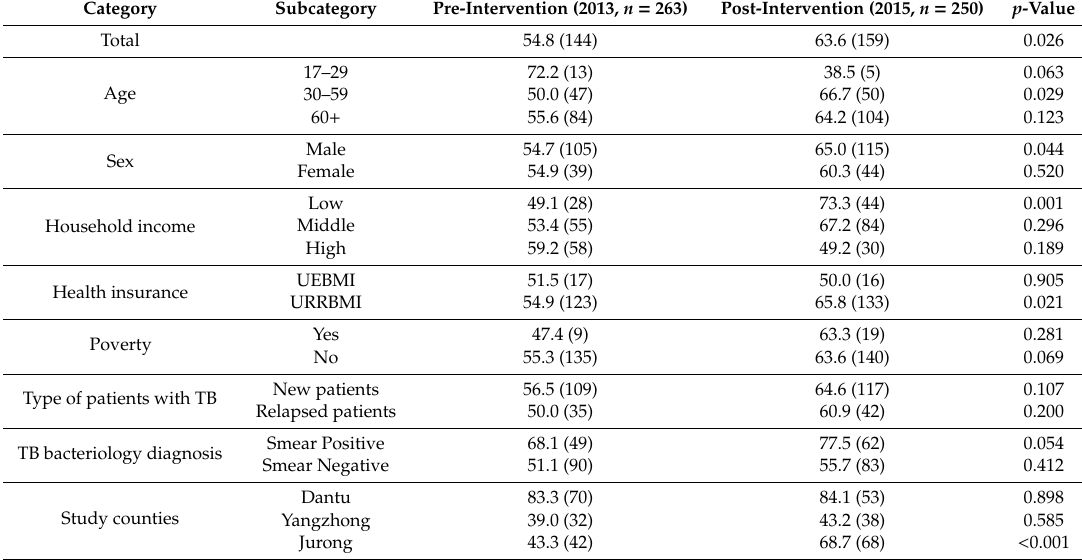
Table 3. Hospital admission rate of patients with TB by patient characteristics in Zhenjiang, in 2013 and 2015, % ( n ).